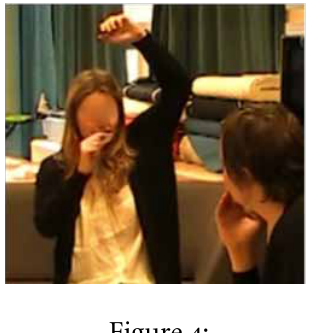
hidden under the wing of the